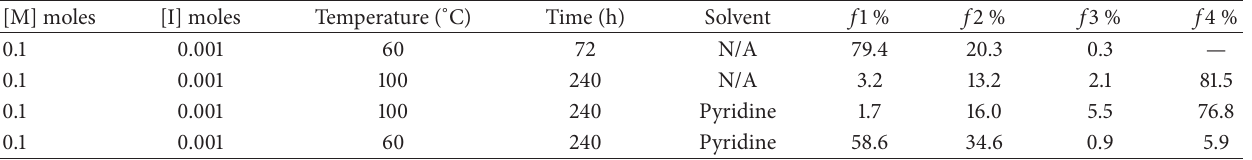
Table 1: Base-catalyzed HTP of acrylic acid at different experimental